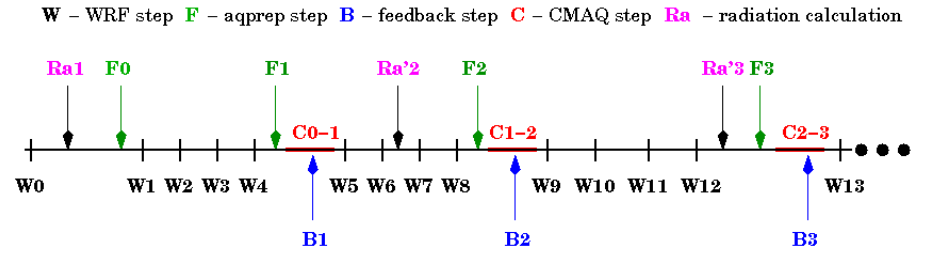
Figure 4. Calling sequence of the coupled system with 4:1 call frequency and radiation is updated every 6 time steps 3